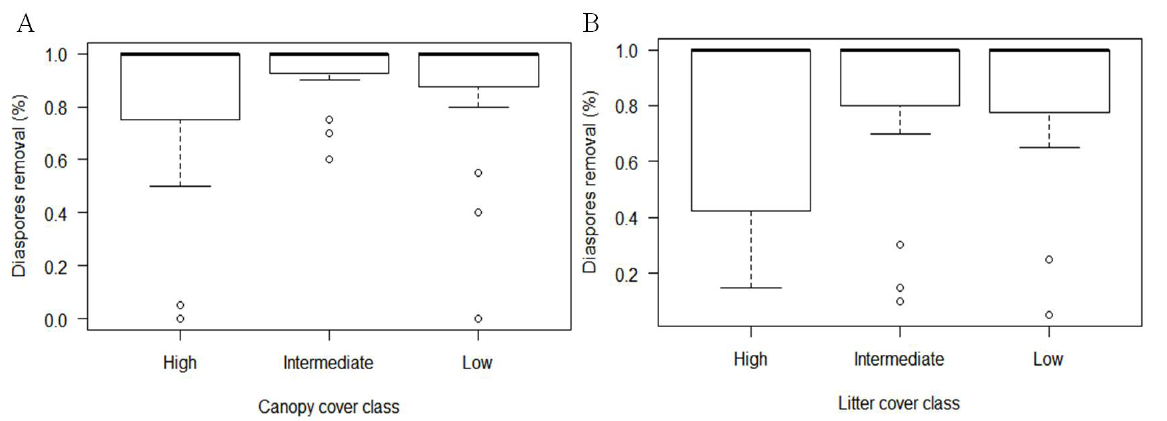
Fig 1 . Proportion of artificial diaspores removed by ants under different (A) canopy cover class and (B) litter cover class in cerrado